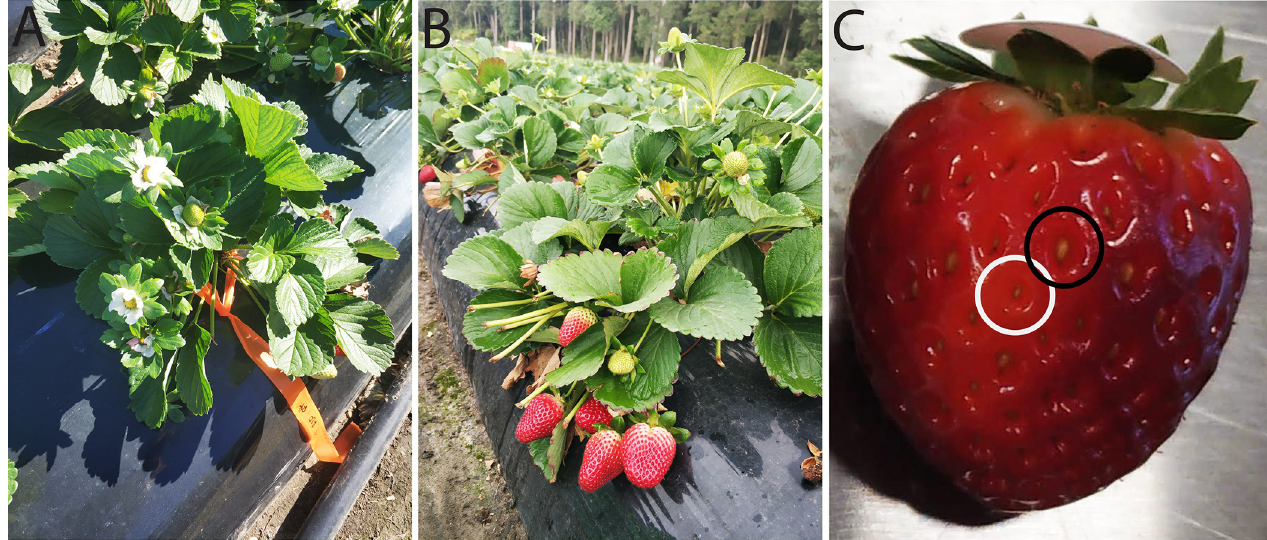
Fig 2. Red Rhapsody and Sundrench strawberry plants (A) during flowering and (B) at harvest, and (C) a Red Rhapsody fruit with an unfertilised seed (white circle) and a fertilised seed (black circle).